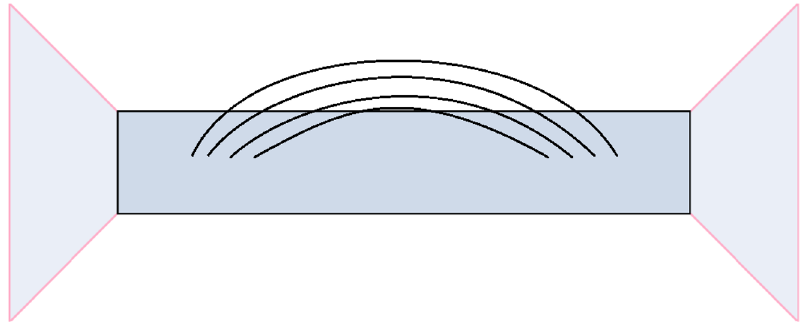
Figure 23 . Coupled evolution of the thermo(cid:12)eld-double state creates a quantum lunch in a classical python. The classical cross-section of the wormhole remains constant in size, but there is long range entanglement between the two sides, which increases the generalized entropy of a cut through the middle of the